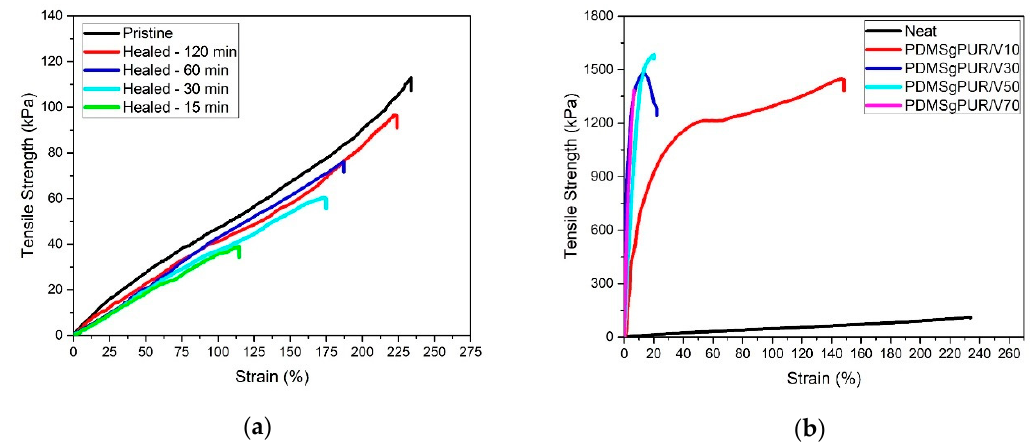
Figure 7. ( a ) Tensile test results of PDMS -g- PUR and healed PDMS -g- PUR as a function of healing time (min) and ( b ) tensile test results of PDMS -g- PUR and PDMS -g- PUR/V 2 O 5 composites.